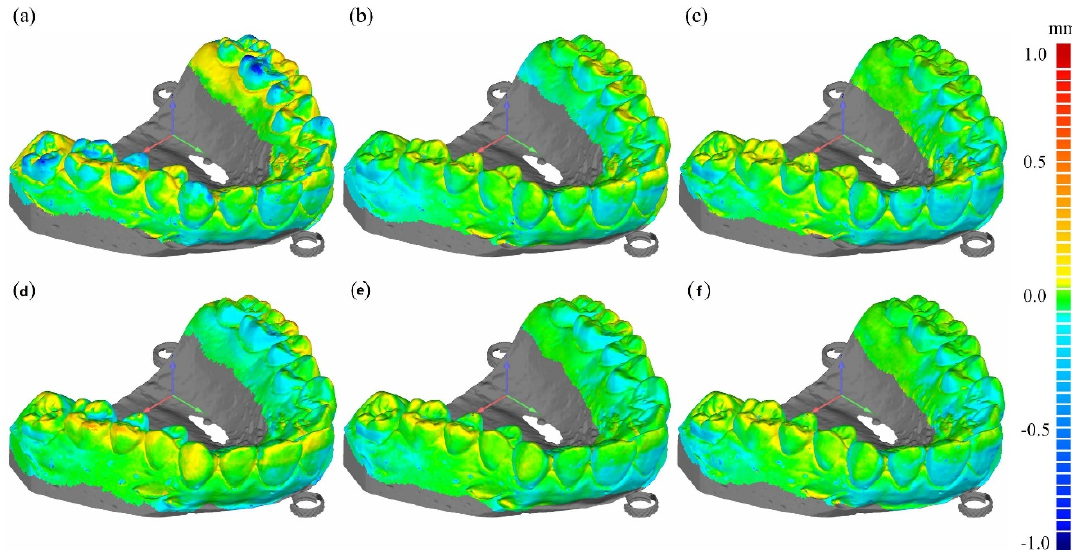
Figure 9. The deviation maps of Model 2 as compared to the optical STL (reference). ( a – c ) show deviation maps computed from the FDK images taken at the cone-beam angles of 10, 5, and 0 degrees, respectively, while ( d – f ) show deviation maps computed from the CW-FDK images taken at the cone-beam angles of 10, 5, and 0 degrees, respectively.